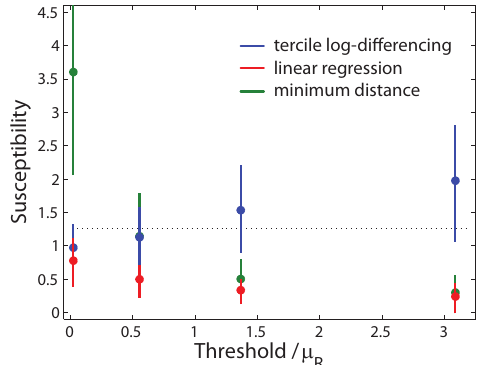
Fig. A3. Susceptibility estimates from TLD (blue), linear regression (red), and minimum distance (green) with increasing noise level. Dots represent mean susceptibilities based on 100 estimates, and the lines show middle 95% interval. The abscissa shows the ratio between the standard deviation of the distribution from which the noise is taken, σ noise , and the standard deviation of R , σ R , after the noise has been added. The dotted line represents the underlying β value.